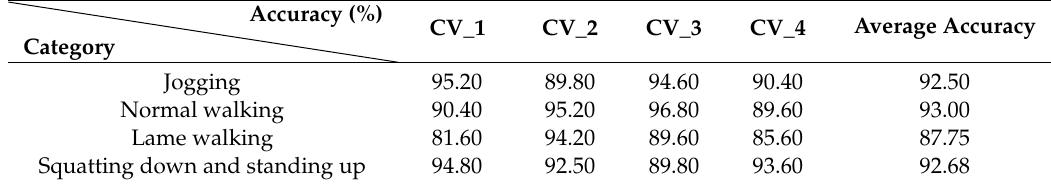
Table 5. Recognition results of cross validation.